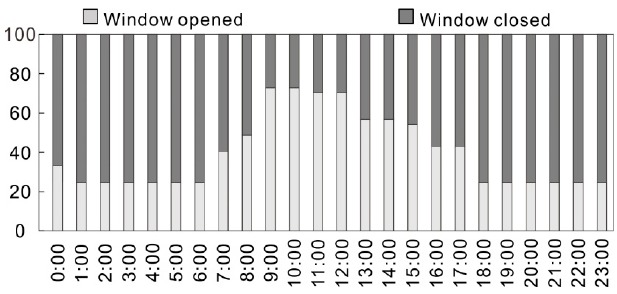
Figure 6. The frequency of opening window at different time.